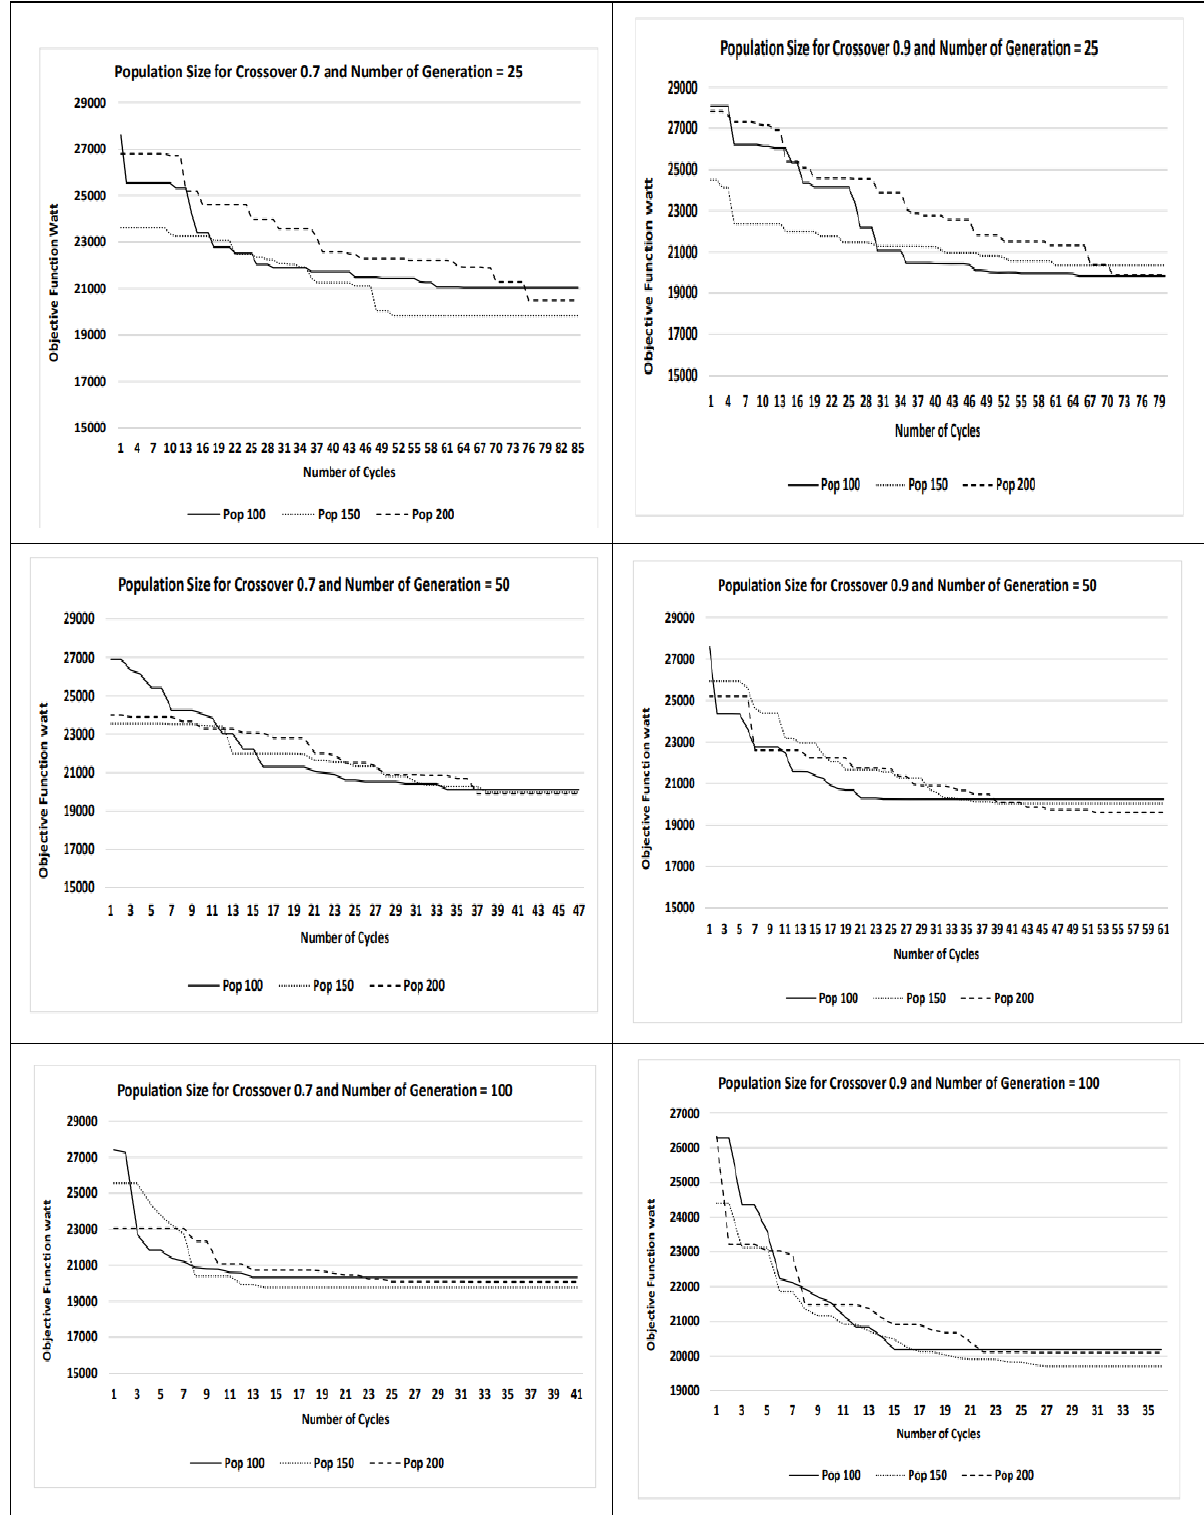
Figure 6. Effect of Population Size on GA’s Convergence.